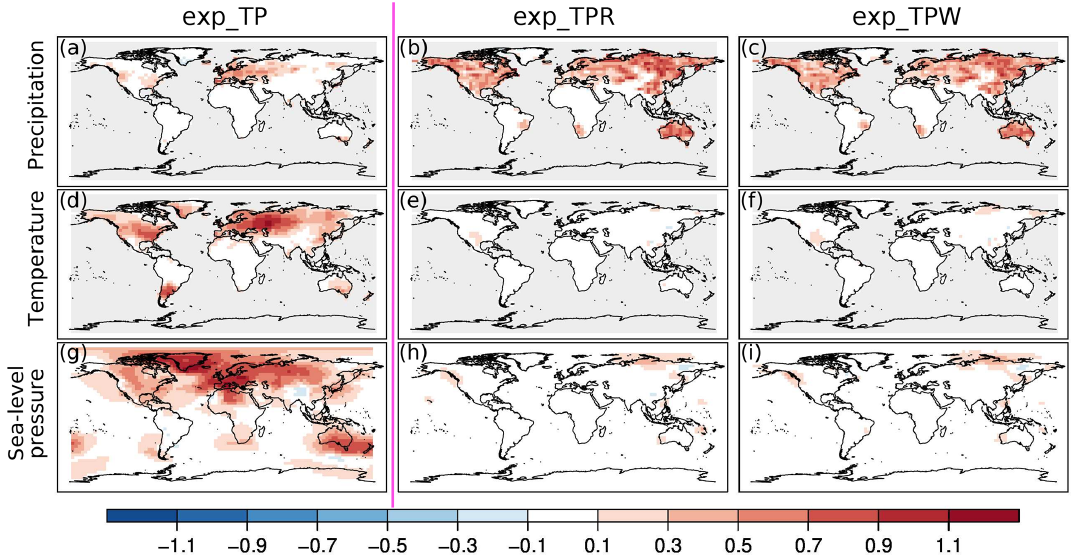
Figure 5. Summer season correlation differences between the analysis of exp_TP and the CCC400 model simulation ensemble means: precipitation (a) , temperature (d) , sea-level pressure (g) . In the middle column (b, e, h) the correlation differences between the ensemble mean of exp_TPR and exp_TP are shown, while in the right column (c, f, i) the correlation differences between the exp_TPR and exp_TP ensemble mean are depicted.